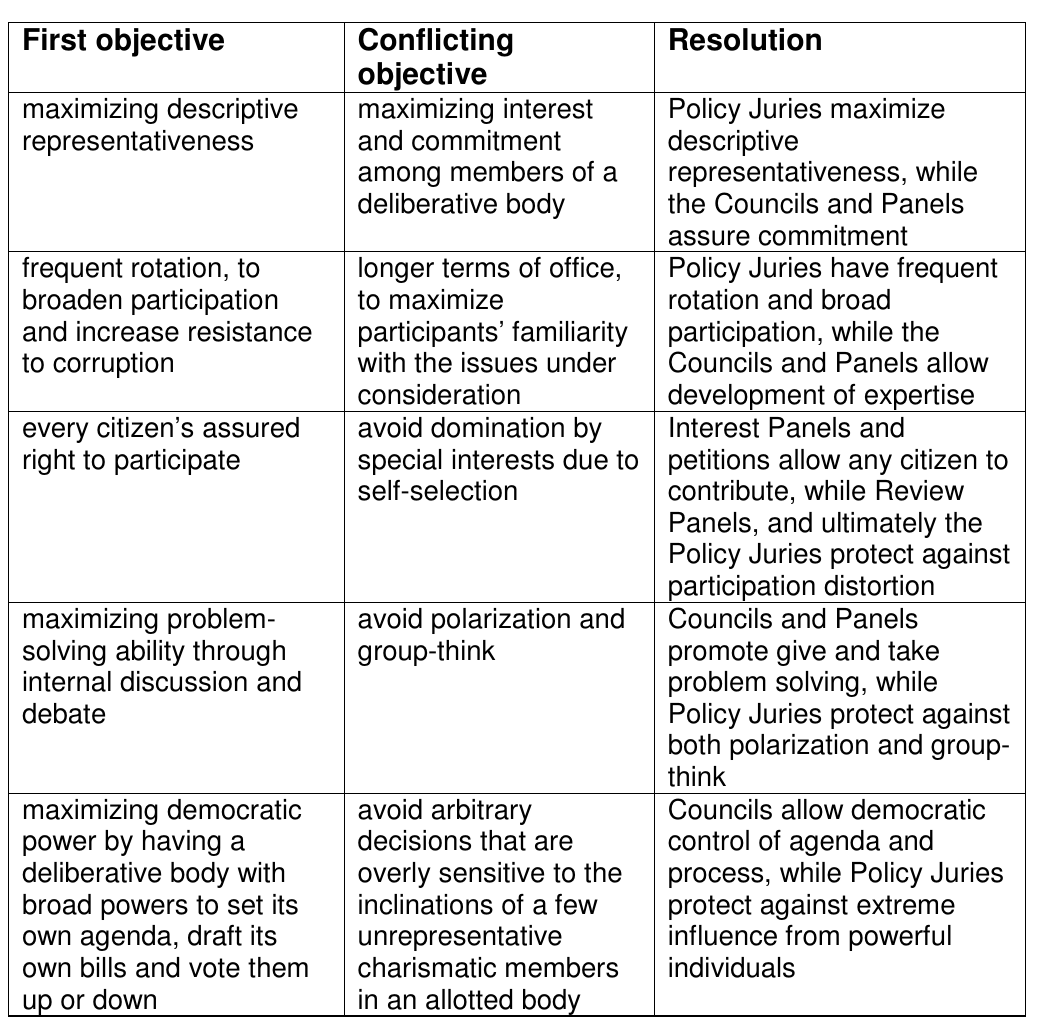
Table 1. Resolution of Dilemmas by Use of Multiple Sortition